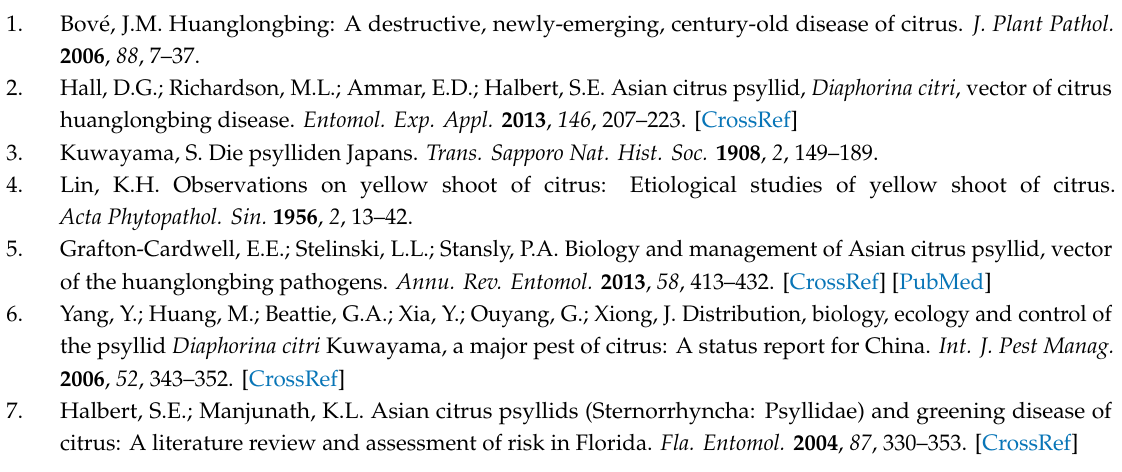
Table S1. The quality statistics of the filtered sequencing data. Table S2. The Nr annotation information for each unigene. Table S3. The top 20 upregulated and downregulated di ff erential expression genes expressed genes at each stage. The stage on the right for each DEG comparison served as the control. Table S4. Gene function analysis software and